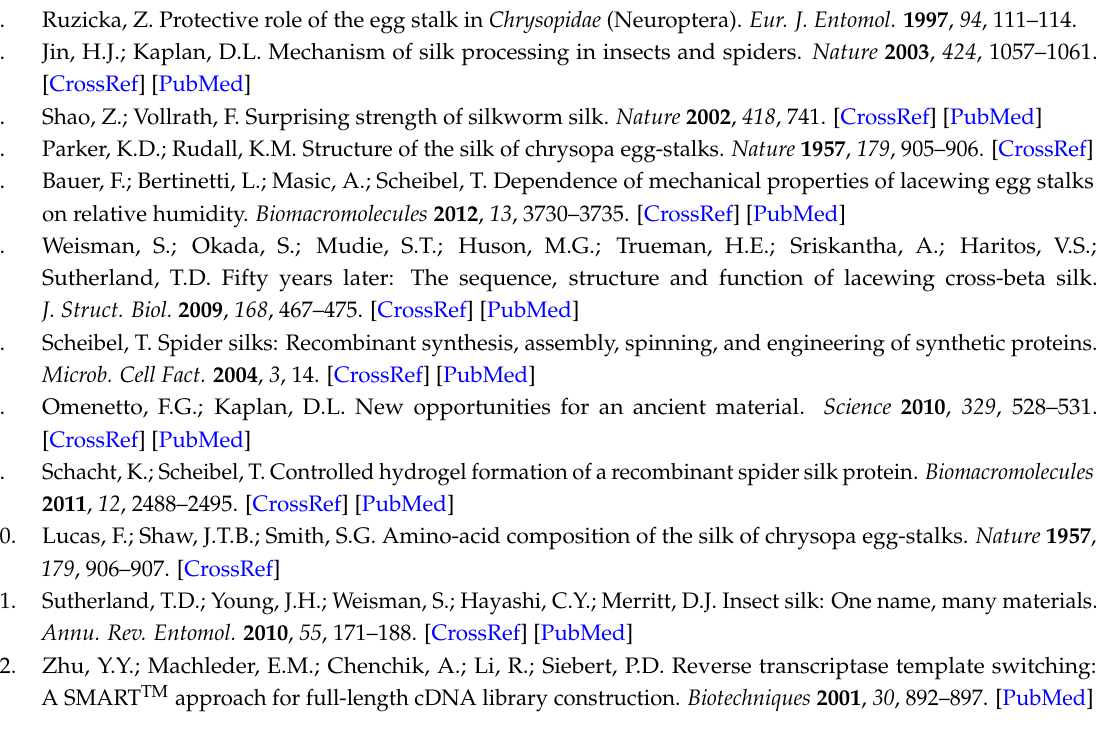
ChryC1, Figure S2: Protein sequence of ChryC2, Figure S3: Protein sequences of all found transcript variants of ChryC1, Figure S4: 1.5% (w/v) agarose gel of qPCR products, Figure S5: CD spectrum of self-assembled ChryC2 fibrils, Figure S6: Fourier self-deconvolution (FSD) of FTIR spectra of self-assembled ChryC1 films, Figure S7: Phylogenetic tree of lacewings according to NCBI